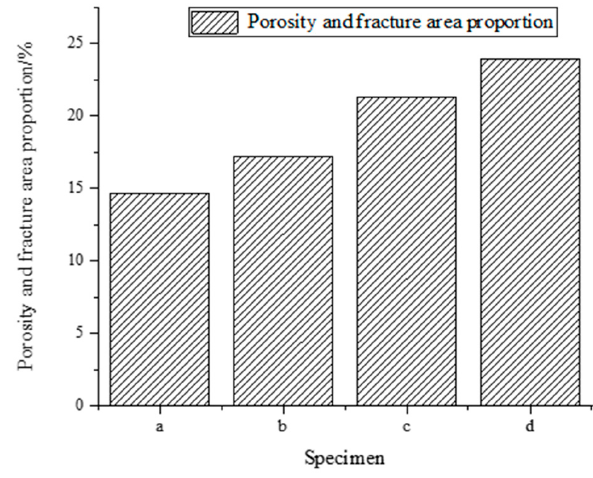
Figure 6. Proportion of pores and cracks in SEM morphology.